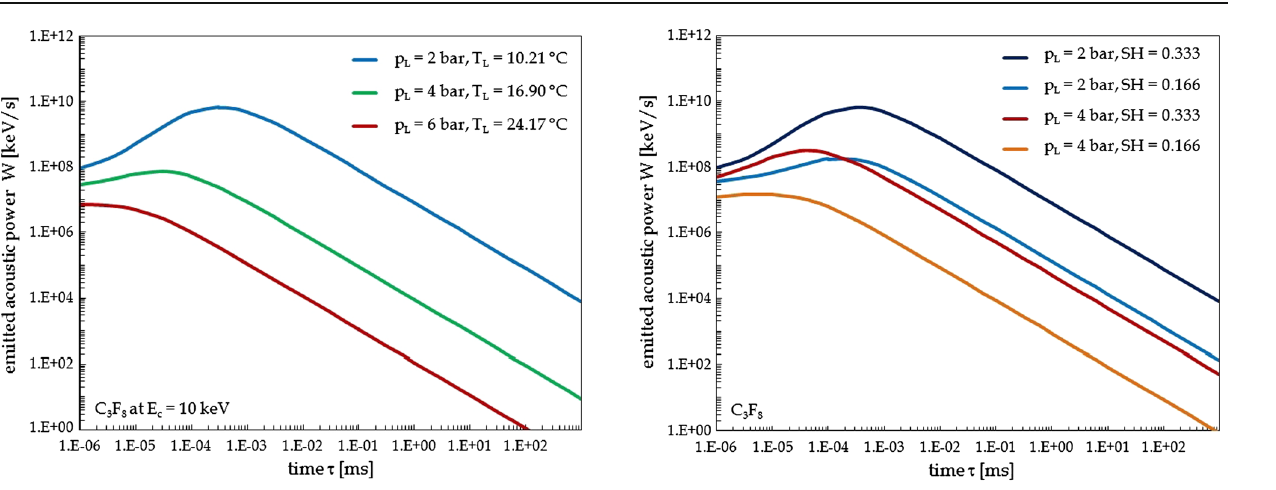
In this regard, it is worth pointing out that, according to Fig. 1, the size reached by the vapour bubble at time τ =